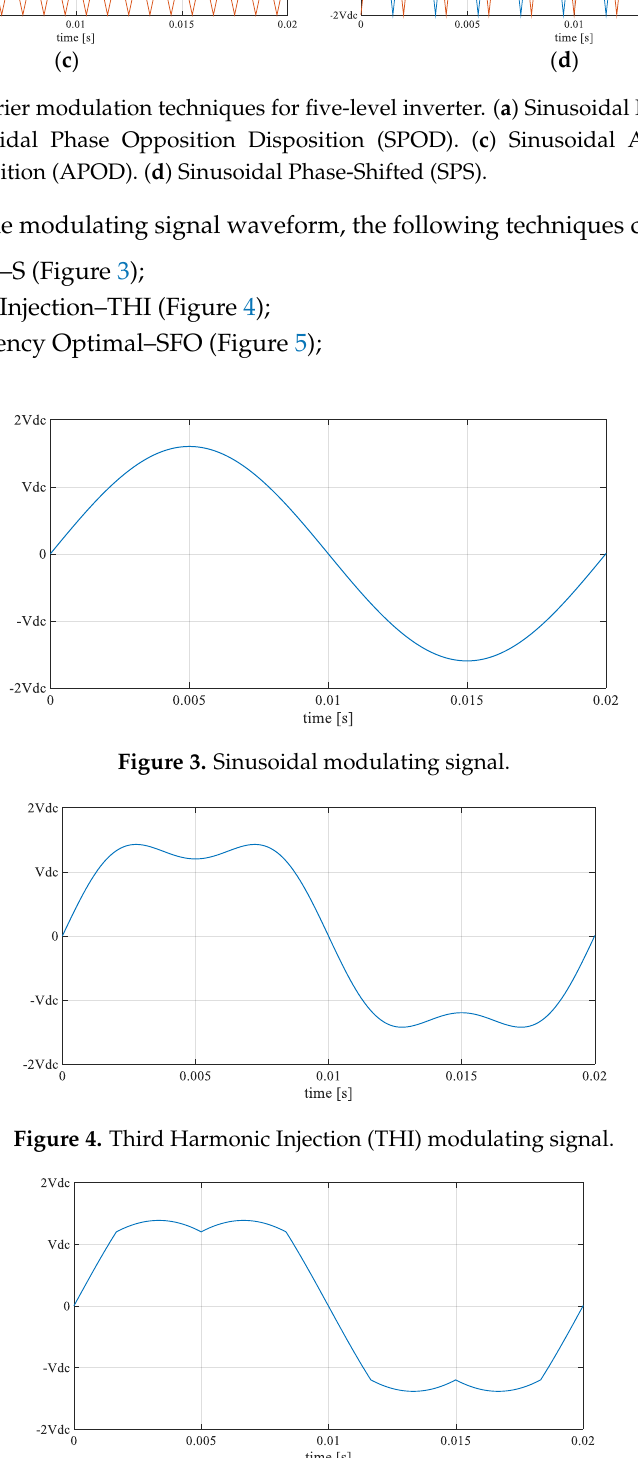
Figure 5. SFO (Switching Frequency Optimal) modulating signal.